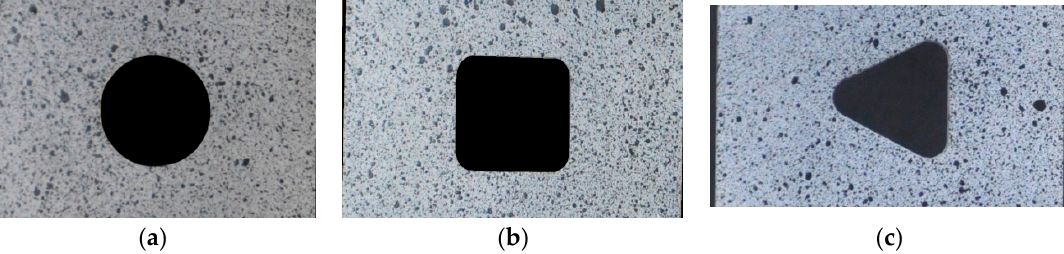
Figure 3. Mid-side parts of samples with holes made of S235JR + N and coated by speckle pattern: ( a ) circular hole φ 30; ( b ) rectangular hole; and ( c ) triangular hole.